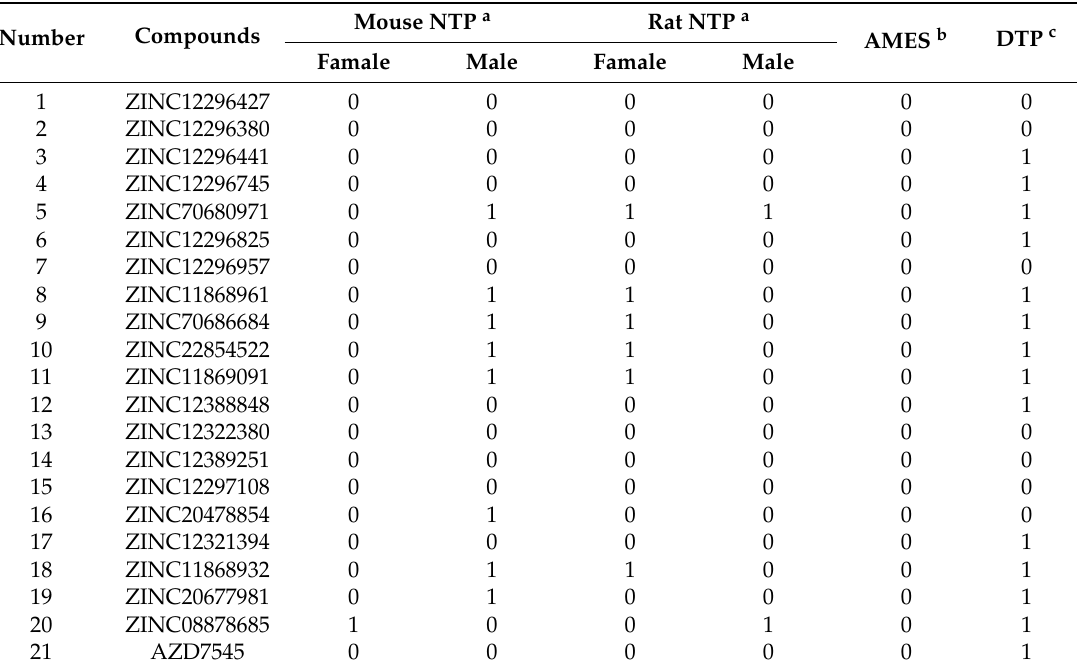
Table 3. Toxicities of compounds.